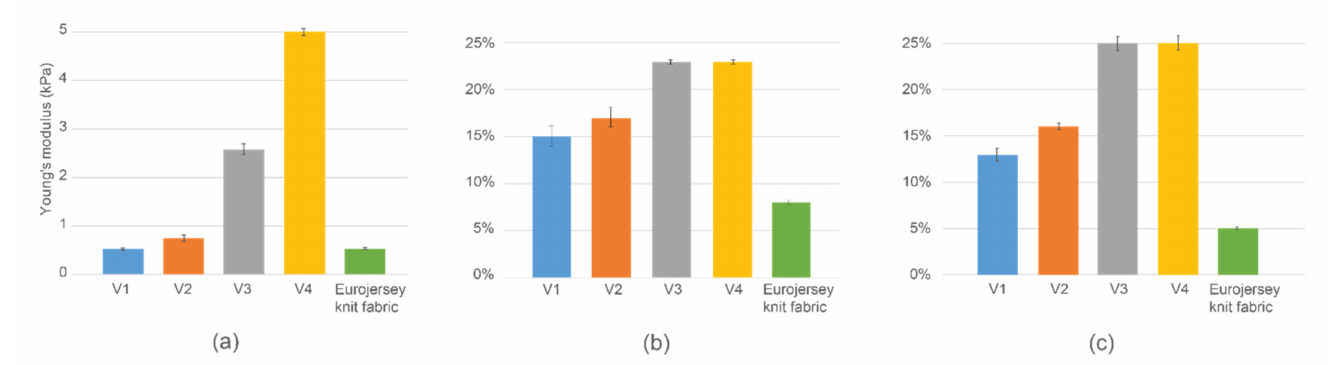
Figure 6. ( a ) Young’s modulus comparison. ( b ) Stress decay after 10 s holding period in 100th tensile test cycle. ( c ) WiM difference between first and last tensile test